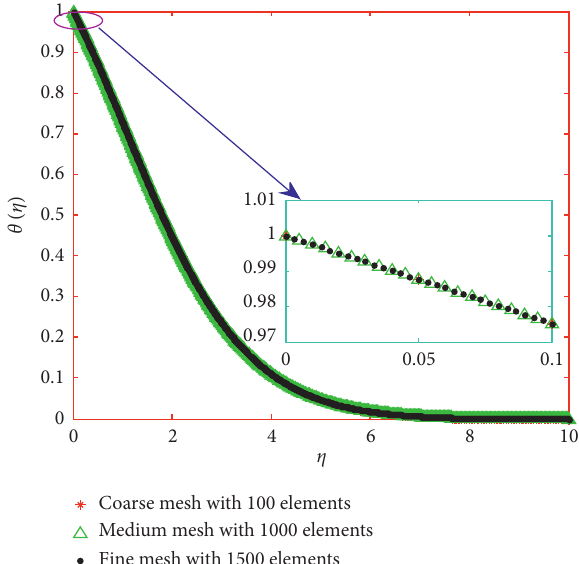
Figure 28: Grid-independence test showing every fifth element of the mesh for temperature profile.